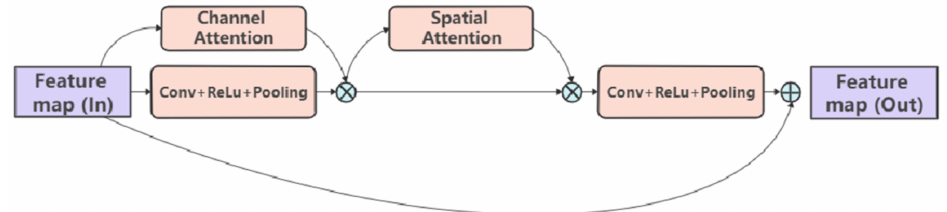
Figure 1. ResNet’s basic block that increases the spatial attention and channel attention. The two concatenated convolution modules are the original parts of ResNet’s basic block. In the middle of the bipolar convolution module, the channel attention module and the spatial attention module are added to adjust the value of the feature map